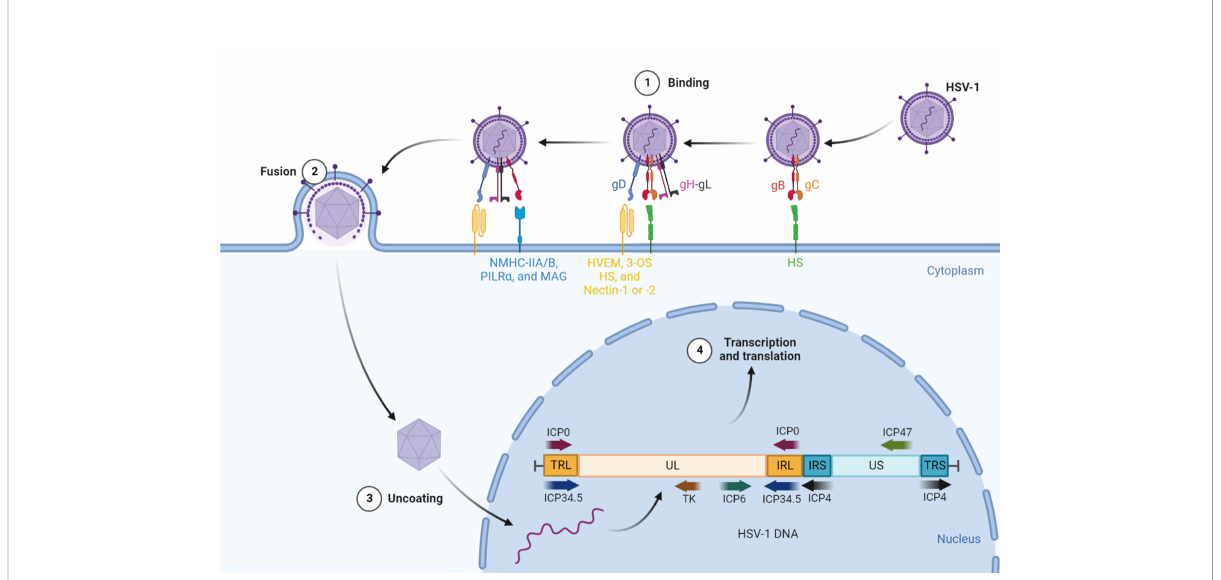
FIGURE 4 The internal structure and invasive process of HSV-1. HSV-1 requires viral binding to speci fi c receptors to trigger membrane fusion to enter host cells. First, gB and/or gC binding to HS facilitates viral adsorption to the cells. Then, one of several entry receptors, including HVEM, Nectin-1 or -2, and 3-OS HS, can bind to gD to stabilize the attachment and promote the formation of the gH-gL complex. Subsequently, the gH – gL complex activates gB to interact with NMHC-IIA/B, PILR a or MAG. Finally, the gD, gB, and gH-gL complexes and their cognate receptors form the core fusion complex to initiate the fusion reaction of the viral envelope with the cytoplasmic membrane. The genomic DNA of HSV-1 is divided into UL, US, TRL, IRL, TRS, and IRS, which can be segmented into immediate-early (IE), early (E) and late (L) for their respective functions. HSV-1, herpes simplex virus type 1; gB, gC, gD, gH, and gL, viral entry glycoproteins; HS, heparan sulfate; HVEM, herpesvirus-entry mediator; 3-OS HS, 3-O-sulfated heparan sulfate; NMHC-IIA/B, non-muscle myosin heavy chain II A/B; PILR a , paired immunoglobulin-like receptor a ; MAG, myelin-associated glycoprotein; UL/US, unique sequence of the long/short region; TRL/IRL, terminal/internal inverted repeat sequence of the long region; TRS/IRS, terminal/internal inverted repeat sequence of the short region; ICP, infected cell protein; TK, thymidine